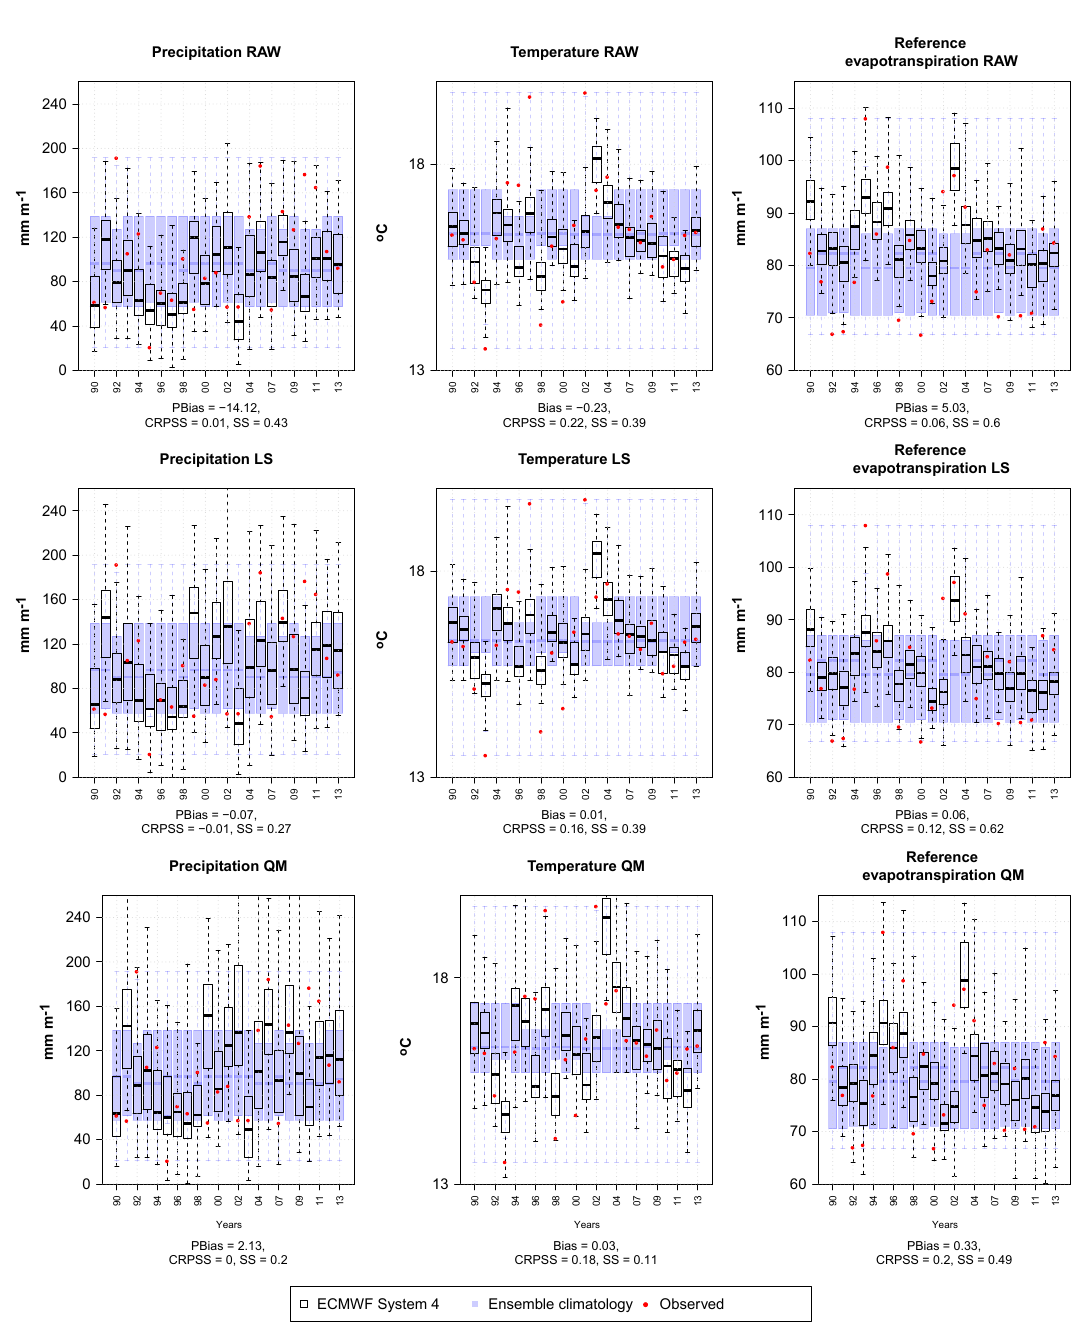
Figure 2. Example of a monthly forecast, valid for August and a lead time of 1 month for a grid point located in west-central Denmark. Blue box plots are the ensemble climatological forecasts. Black box plots are ECMWF System 4 raw or post-processed forecasts. Red dots represent observed values. Bias as in Eqs. (4) and (5) and skill scores for accuracy and sharpness (CRPSS and SS) as in Eq. (8). The first column corresponds to the raw forecast; the second and third columns correspond to the corrected forecasts with the linear scaling or delta change (LS) and quantile mapping (QM) methods,